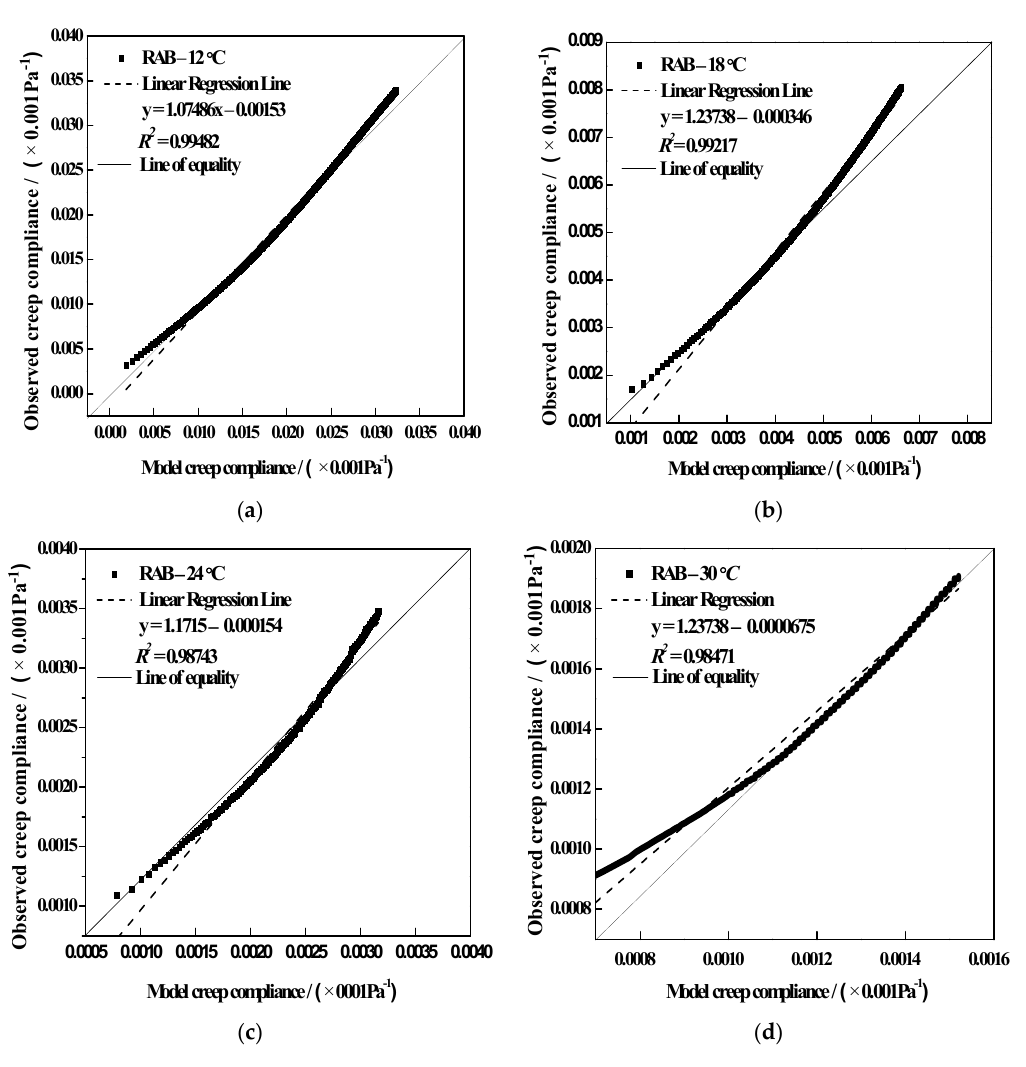
Figure 11. D ( t ) values of simple fractional viscoelastic model versus experimental results for RAB